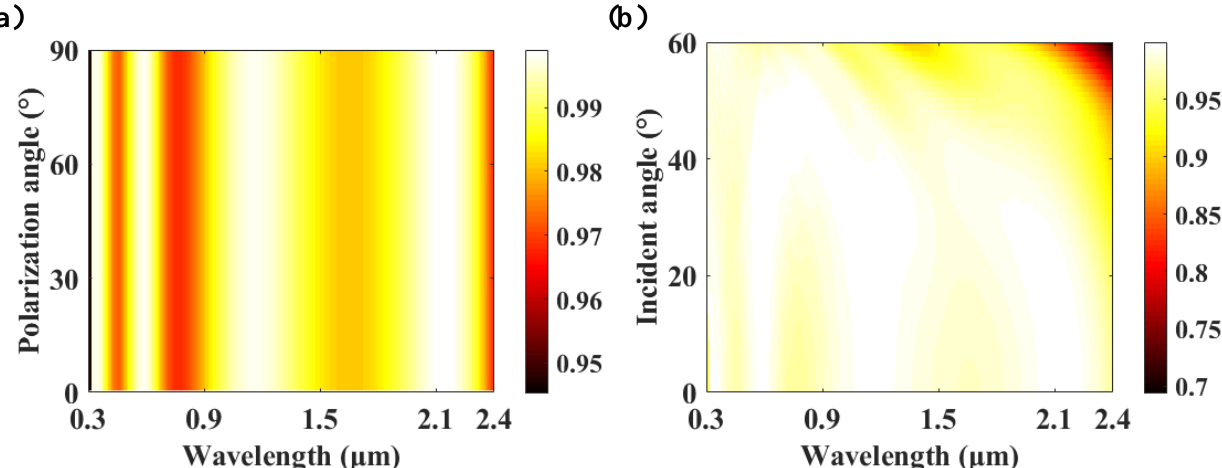
Figure 9. The absorption spectra of the default absorber with the polarization angle varying in the range of 0–90° and the incident angle varying in the range of 0–60°. ( a ) The dependence of absorption properties of the absorber on the polarization of the light. ( b ) The effects of incident angles of the light on the absorption properties of the proposed absorber.